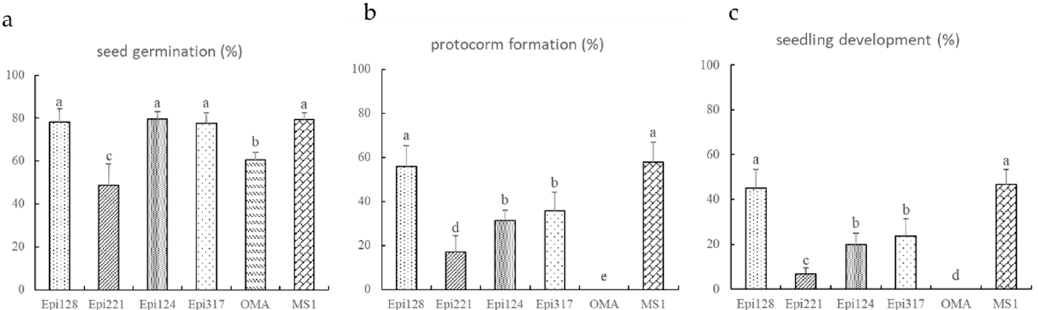
Figure 5. Rates of seed germination ( a ) and protocorm formation ( b ) after 30 days of germination; seedling development ( c ) after 90 days of germination.